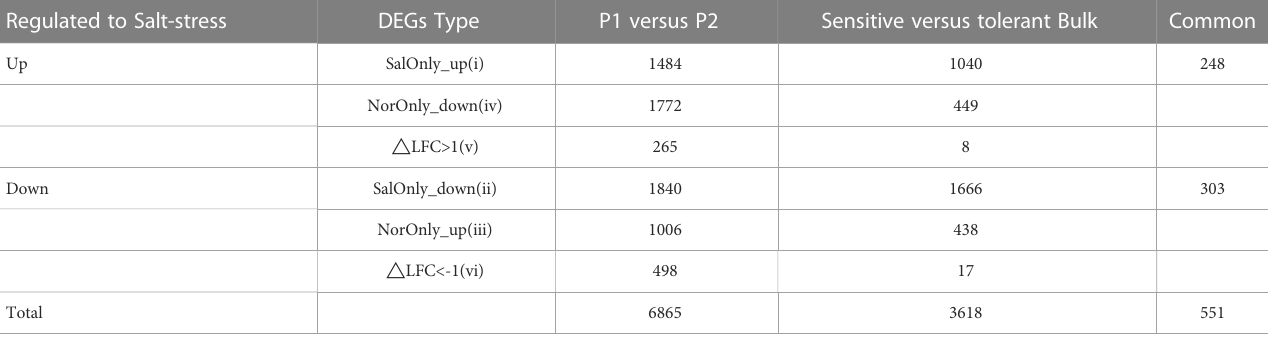
TABLE 5 Number of genes which were differentially regulated between susceptible or tolerant genotypes in response to satt stress, according to their classi fi cation in the six classes. Regulated to Salt-stress